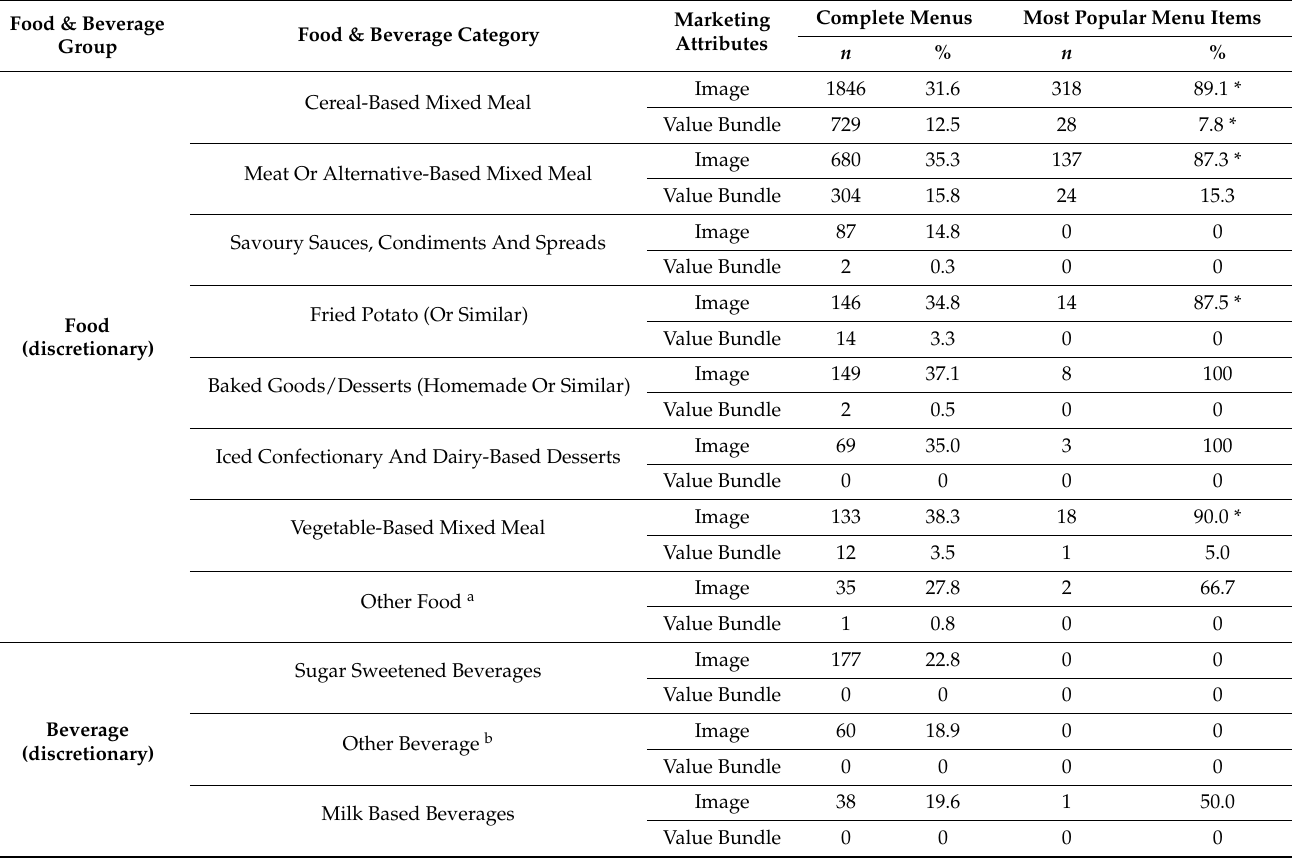
Table 4. Prevalence of images and value bundles for complete menus ( N = 13,841) and most popular menu items ( n = 625) of 196 independent takeaways 1